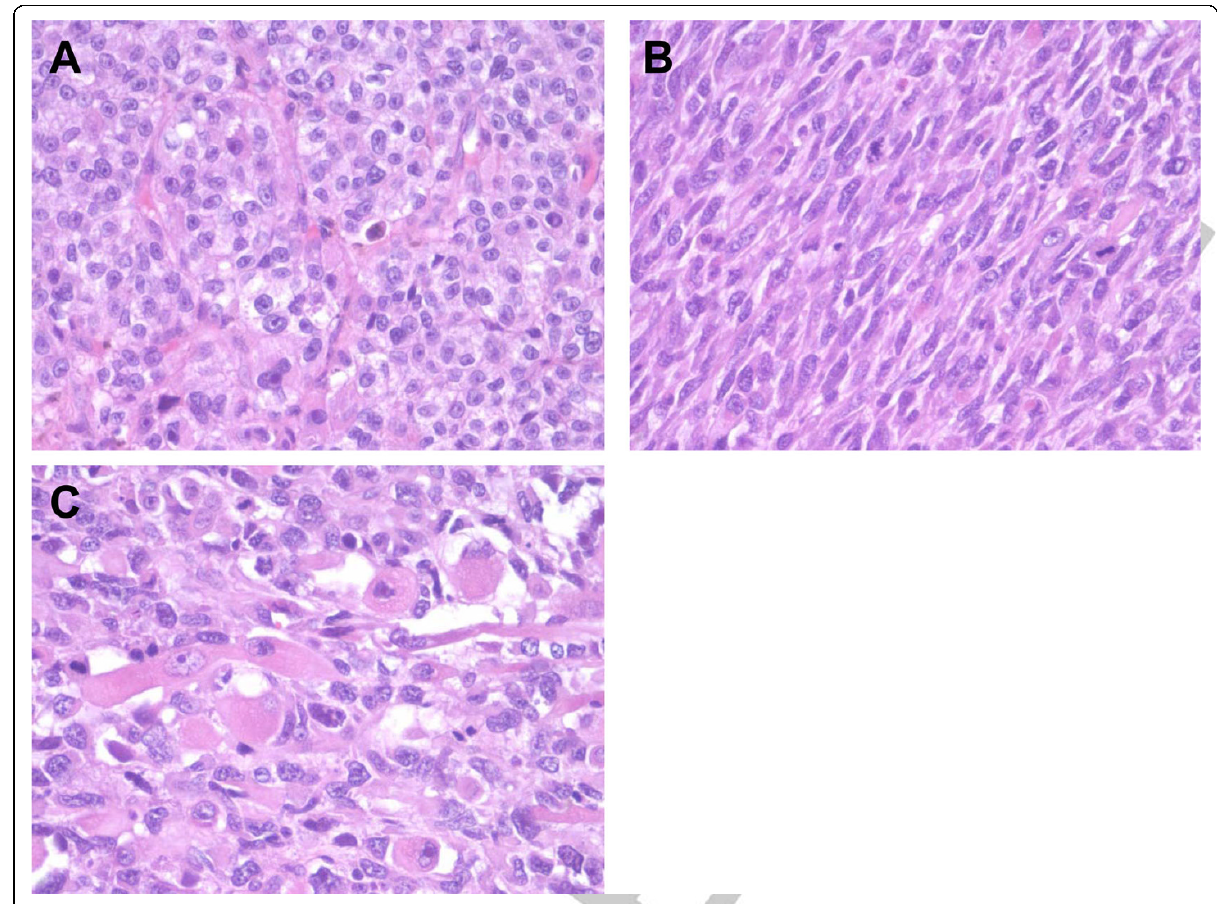
Figure 3 Adrenocortical carcinosarcoma histological appearance . A. Carcinomatous component showing epithelioid cells with clear to eosinophilic cytoplasm arranged in nested pattern (40×). B. Sarcomatous component composed of uniform spindle cells arranged in a fascicular pattern (40×). C. Sarcomatous component showing elongated or ovoid rhabdomyoblastic tumor cells with eccentrically located nuclei and deeply eosinophilic cytoplasm